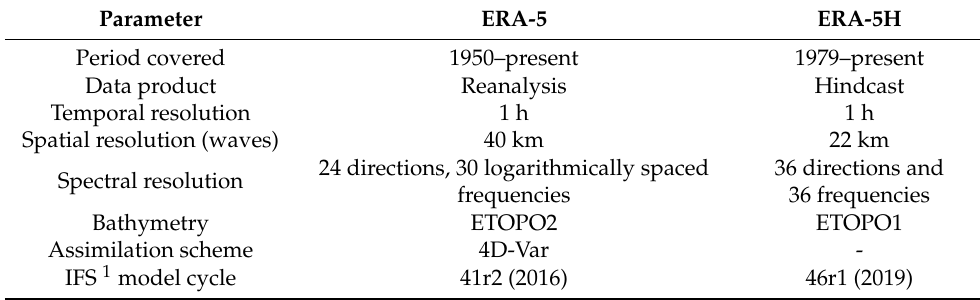
Table 1. Comparison between ERA-5 and ERA-5H information [39].